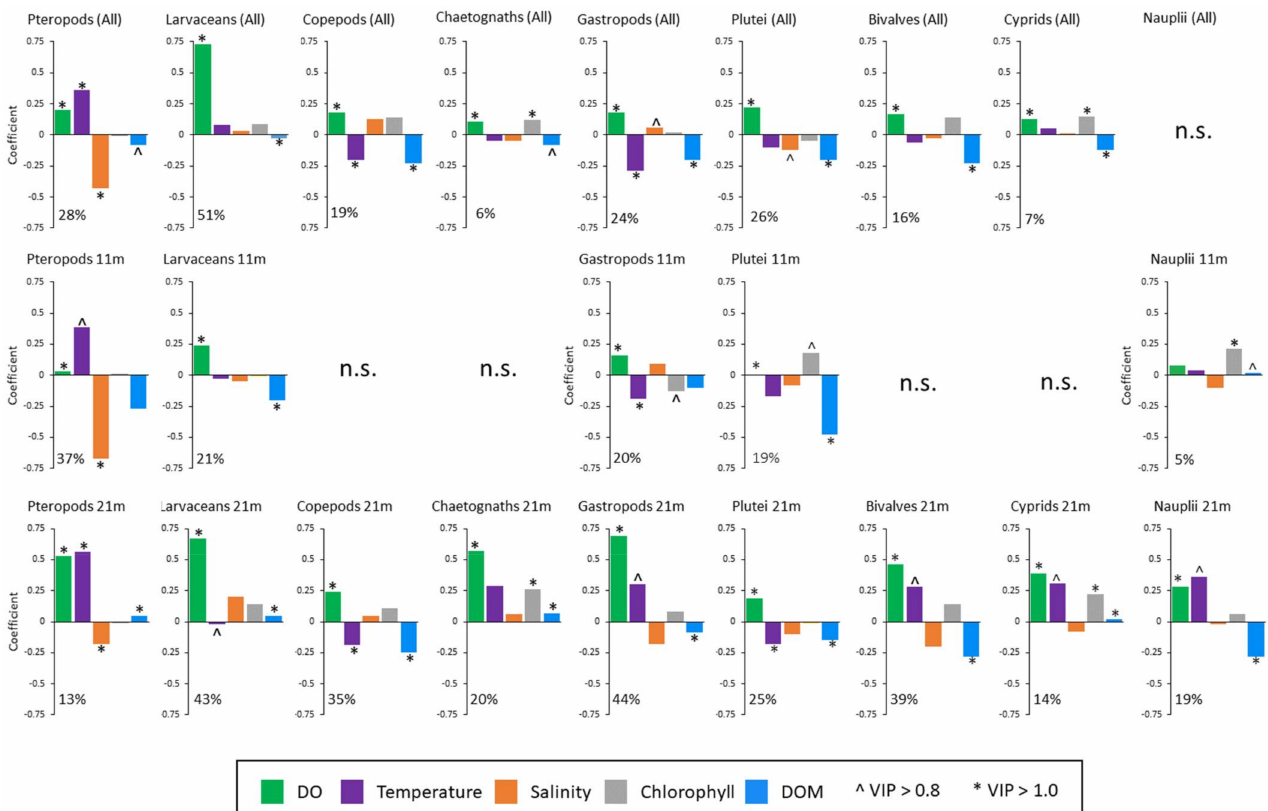
Figure 9. Results from the PLS analyses showing the coefficients for each environmental factor for each group. * VIP > 1.0; ˆ VIP > 0.8; n.s. = not